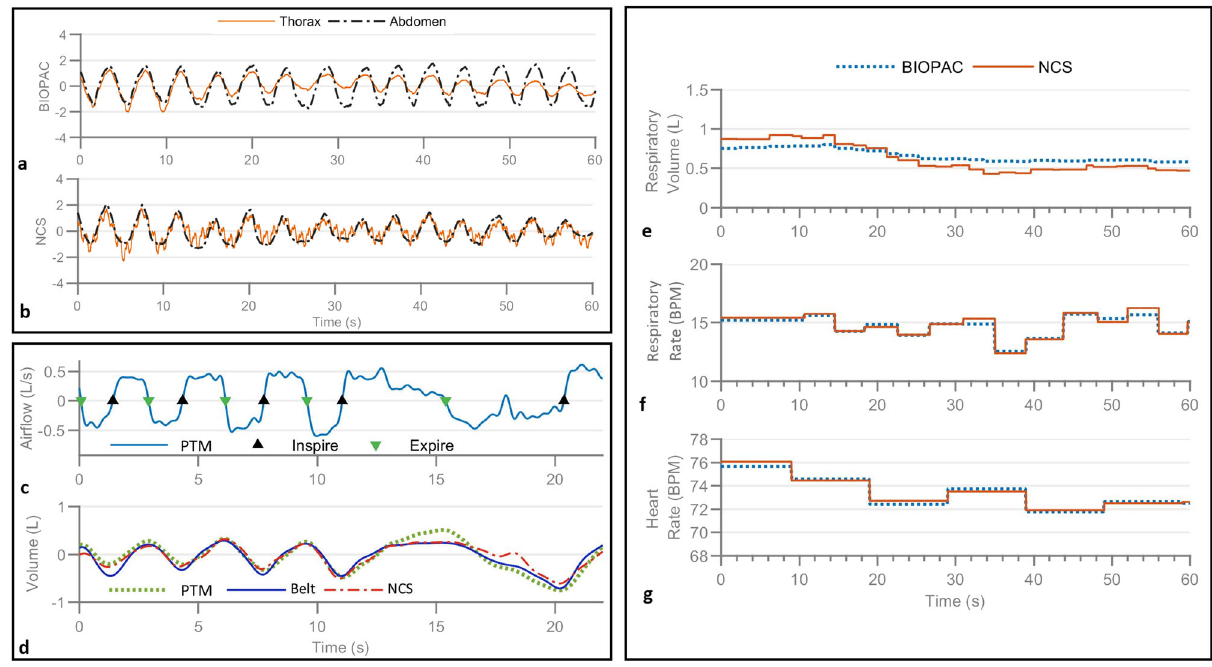
Fig. 2 Examples of the sensor outputs and estimated RV, RR, and HR. a , b The normalized BIOPAC chest-belt signals ( a ) and normalized un fi ltered NCS signals ( b ) showing respiration waveforms during tidal (normal) breathing. The NCS thorax signal shows strong heartbeat motion as well. c The PTM air fl ow signal with detected inspiration and expiration start points. d The extracted instantaneous volume Vol PTM (dotted green) from the air fl ow, and calibrated chest belts (blue) and NCS (dashed-dotted red) respiration volume waveforms. e – g The analysis of the data shown in a and b ; e and f show RV and RR, respectively, from NCS and BIOPAC chest belts; g shows the HR from NCS and BIOPAC